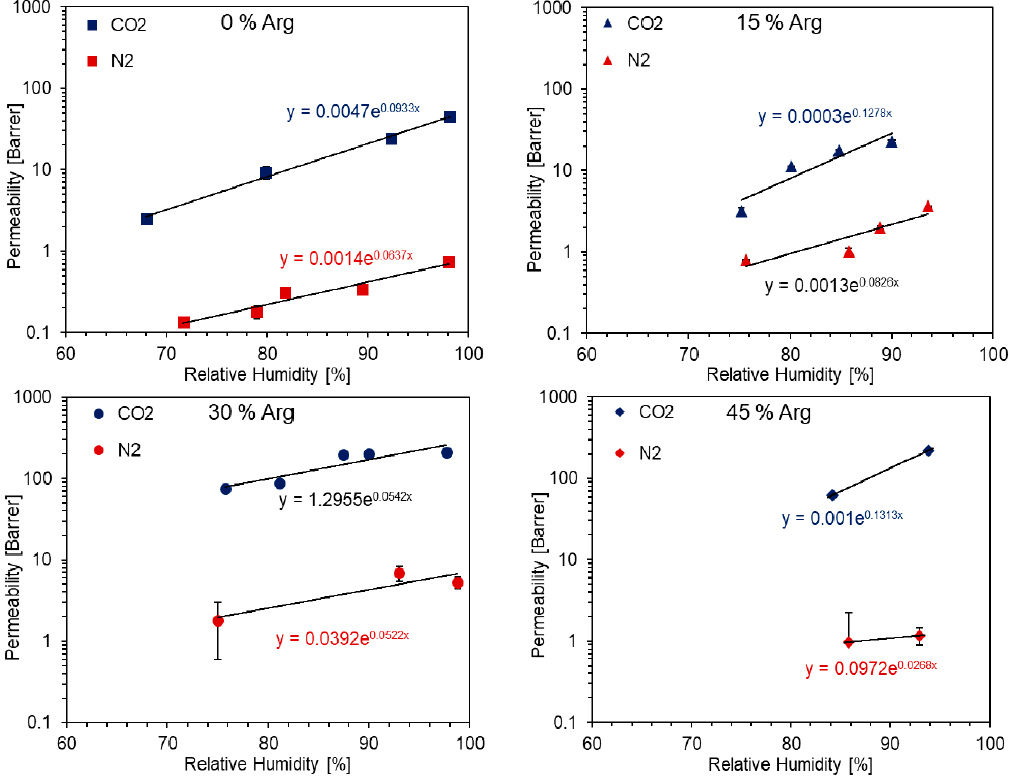
Figure 9. Single-gas permeation results of CMC-NFC with different loadings of arginine with respect to relative humidity.